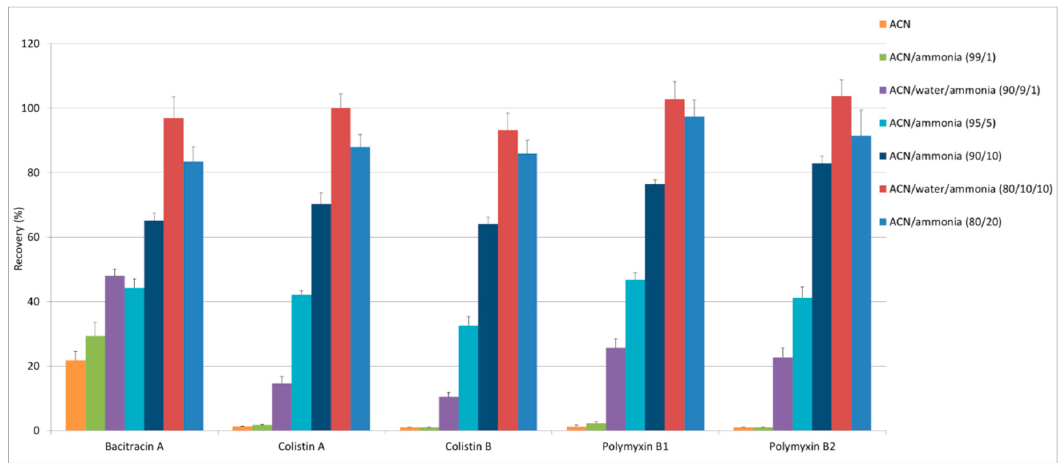
Figure 4. The extraction efficiency of polypeptide antibiotics in different compositions of extraction solvent.